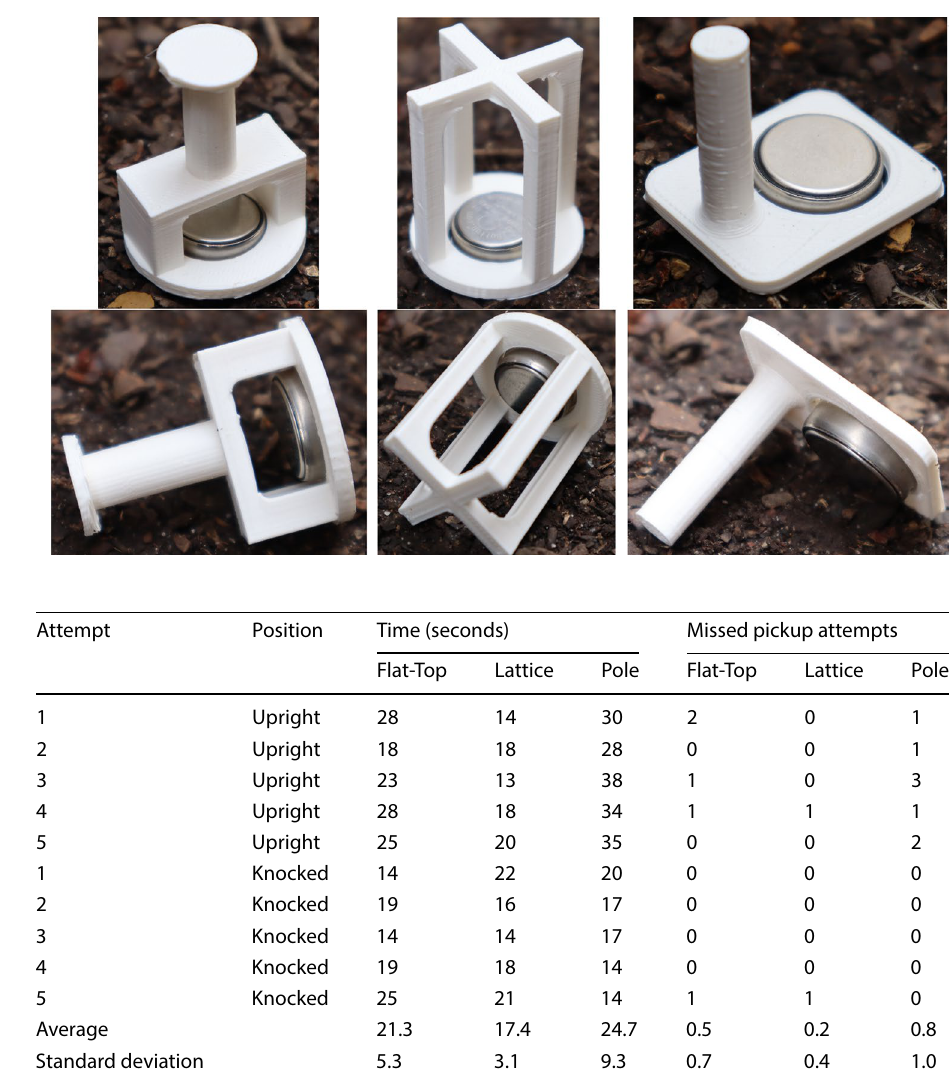
Fig. 7 3D Printed Sensor Holders with sensors inserted (Left-to-Right): Flat-Top, Lattice, Pole ( top —upright, bottom — knocked over)